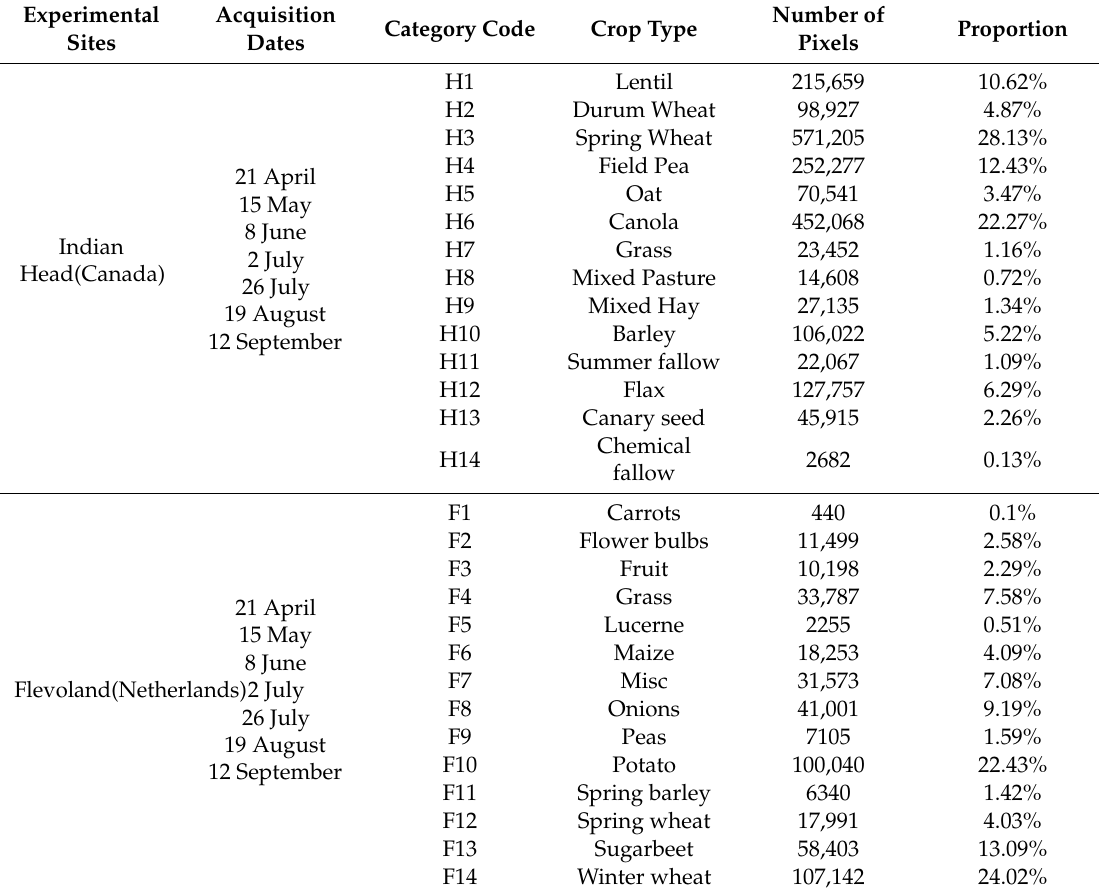
Table 1. Data acquisition dates and basic information of the main crops in the experimental sites.